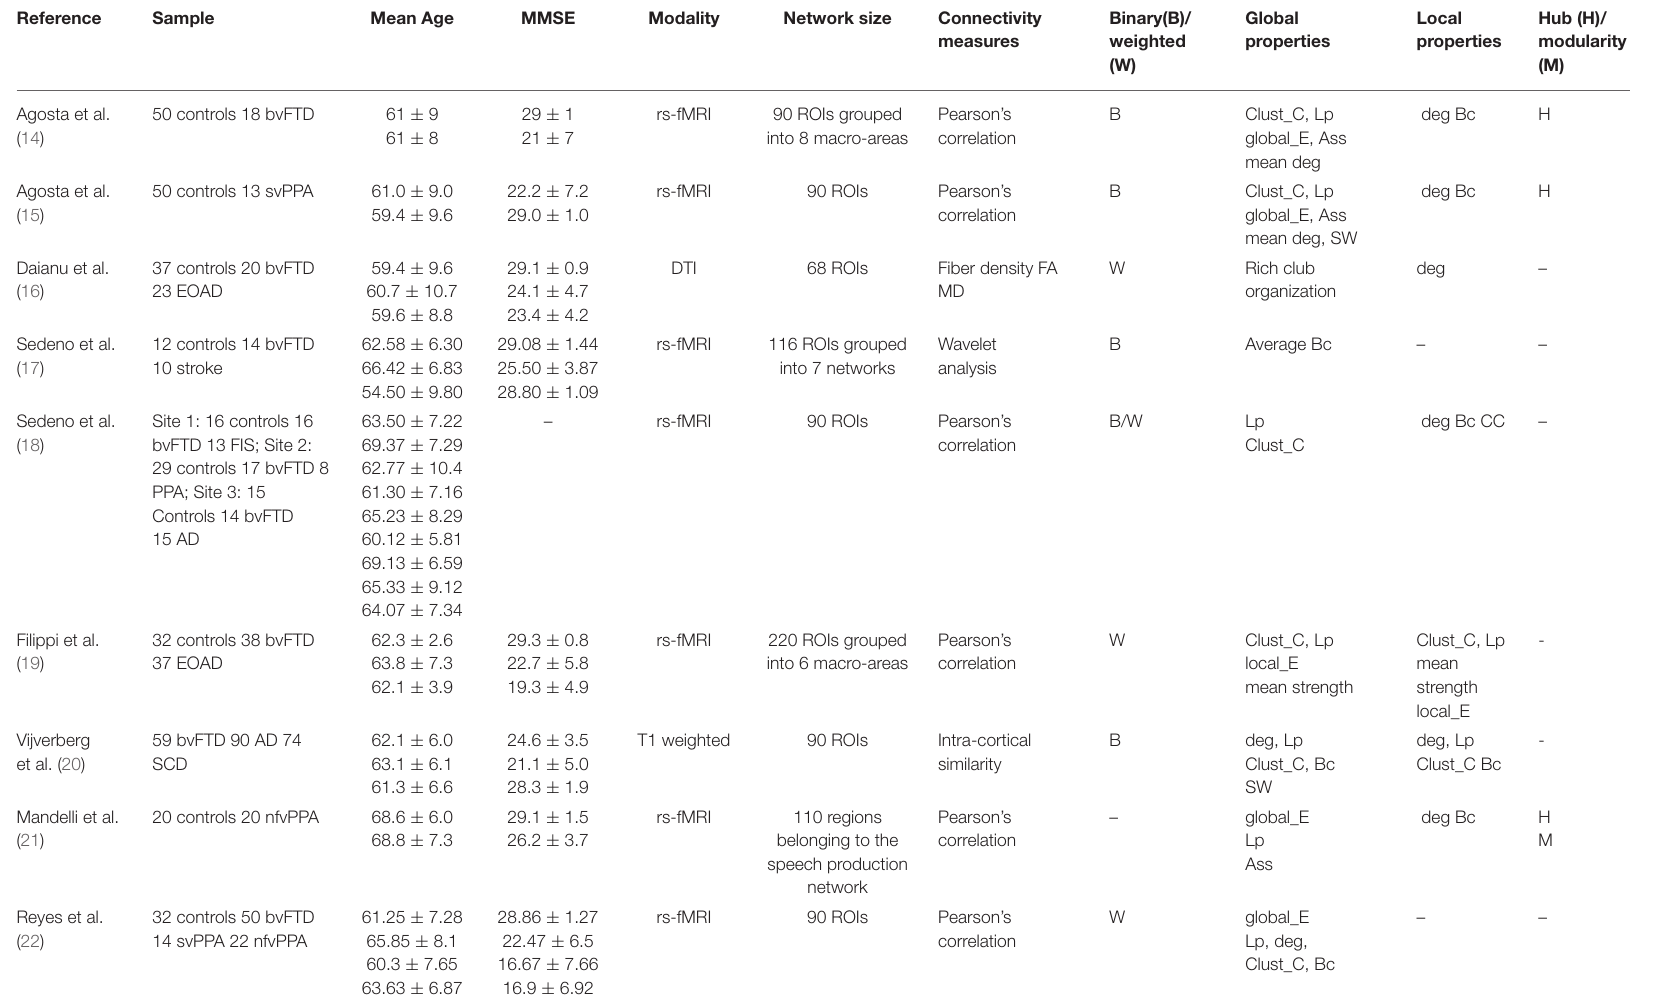
TABLE 1 | Summary of studies that used graph analysis in patients with